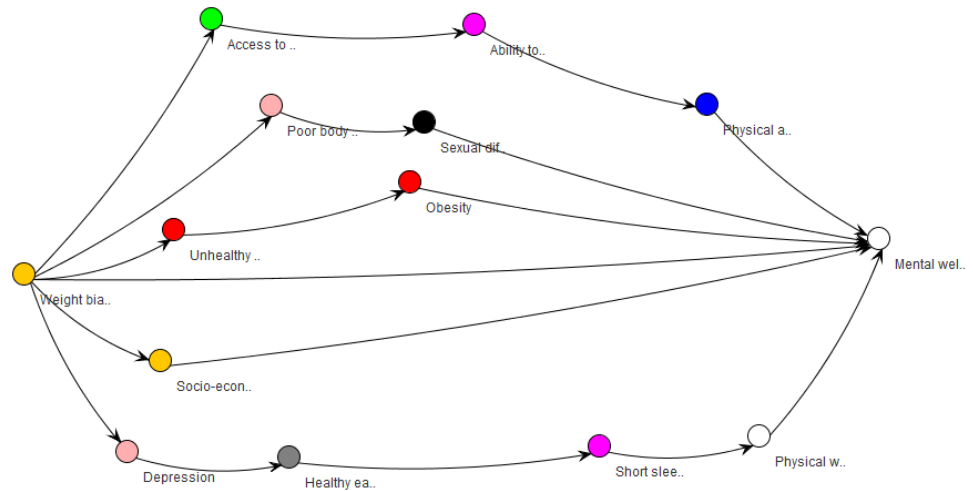
Figure 6. Policymakers are often interested in measuring the consequences of an intervention. In the first version of ActionableSystems , this is supported by choosing an intervention node (e.g., weight bias) and a measurement target (e.g., mental well-being). The intervention will be placed on the left, and all paths that lead to the target can be followed left-to-right in order to identify all parts of the system that would be impacted by the intervention. This visual can reveal unintended consequences, such as impacted sleep duration. Factors that belong to different themes are shown in different colors (e.g., psychological constructs are light pink while well-being constructs are white).